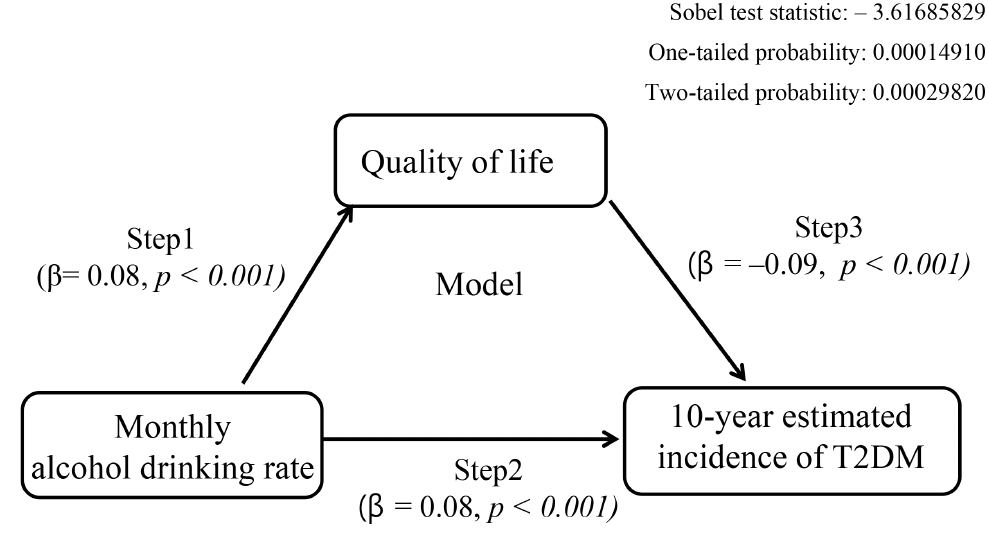
Fig. 2. Mediating effect of quality of life on 10-year estimated incidence of T2DM in Korean adult